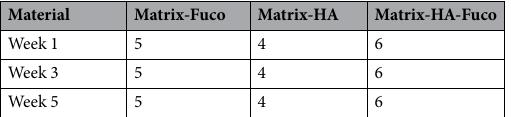
Table 1. Number of samples used per group and per time-point for longitudinal MRI analyses.